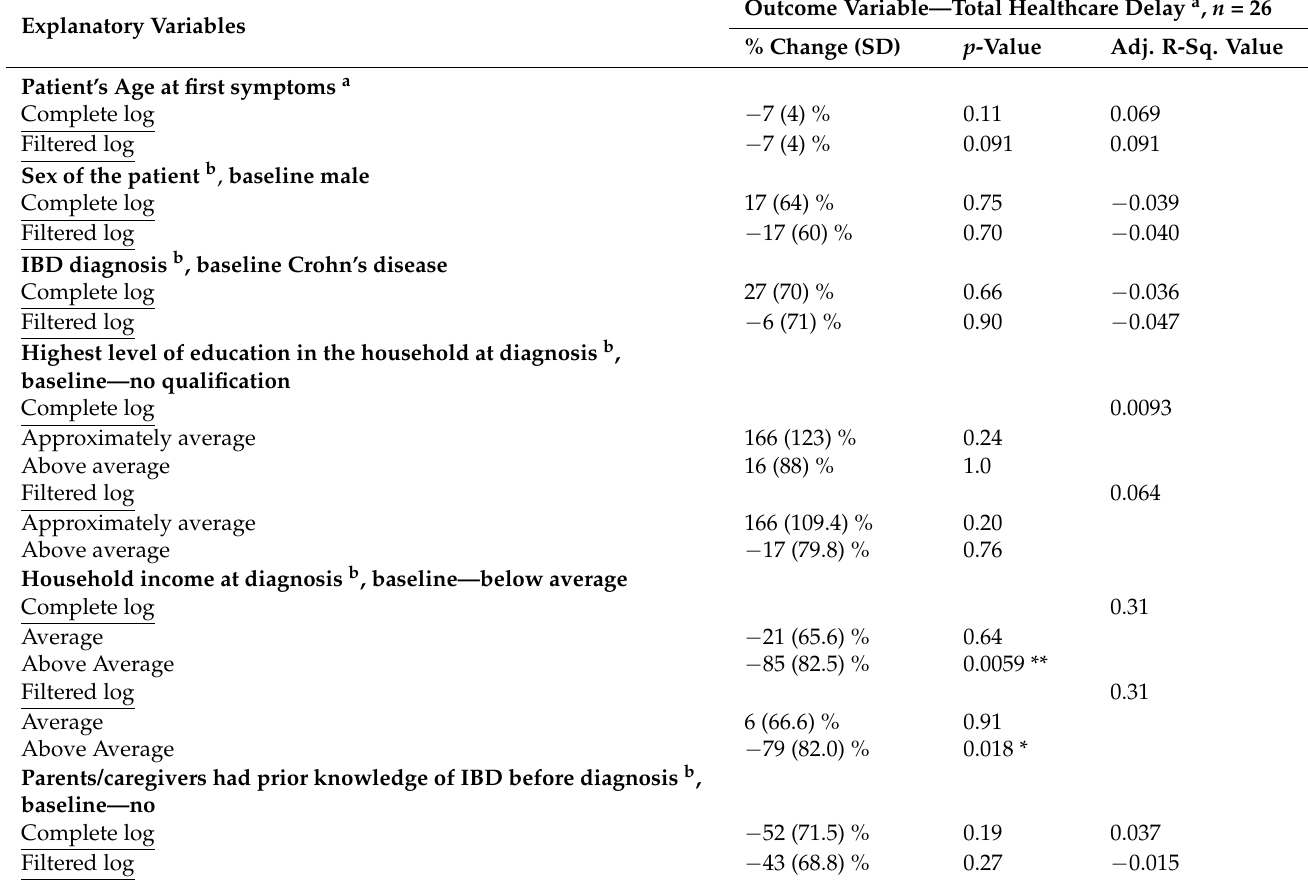
Table A4. Predictors for total healthcare delay. Simple linear